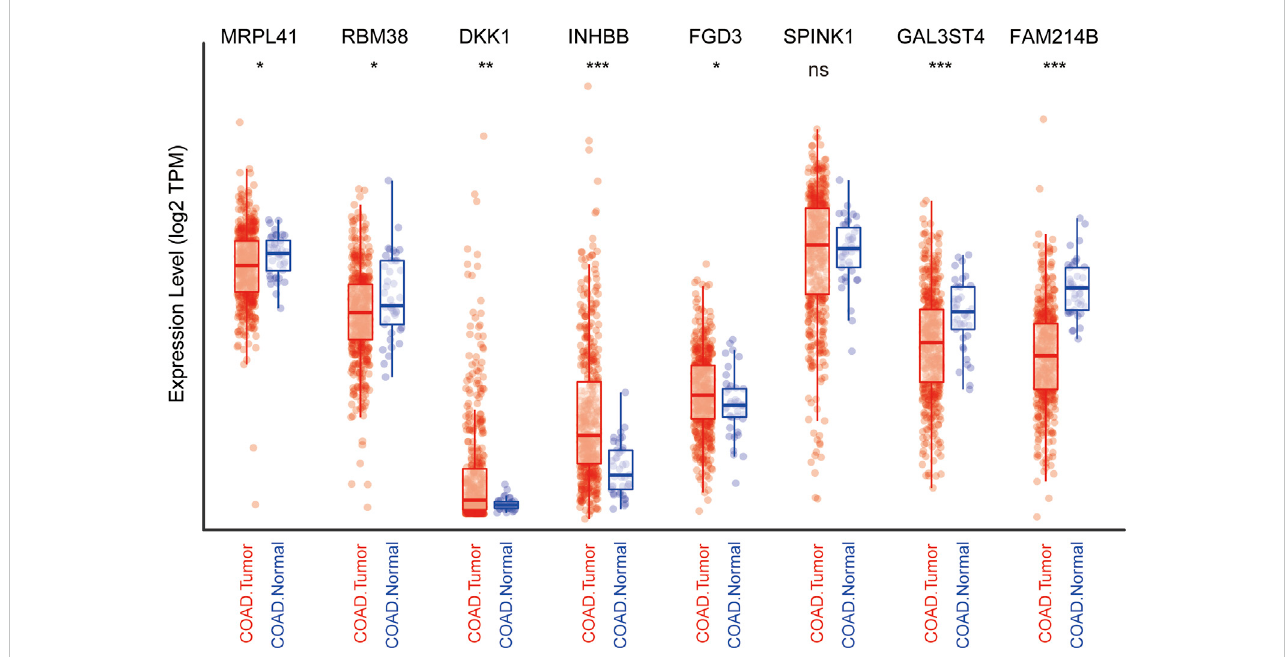
FIGURE 7 Expression pro fi le of the nine genes in TCGA cohort. * p < .05, ** p < .01, *** p < .001, ns: not signi fi